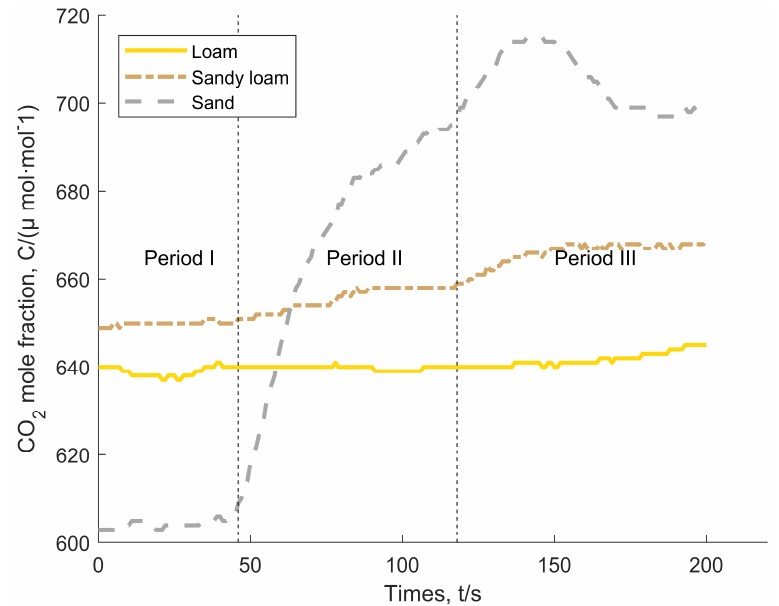
Figure 7. Concentration changes at the O1 layer on the surface of the three soil porous media after aeration reaches steady state.